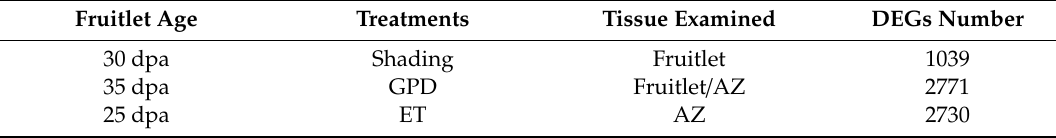
Table 1. A brief summary of three RNA-seq of the fruitlet abscission in litchi. Fruitlet Age Treatments Tissue Examined DEGs Number Shading